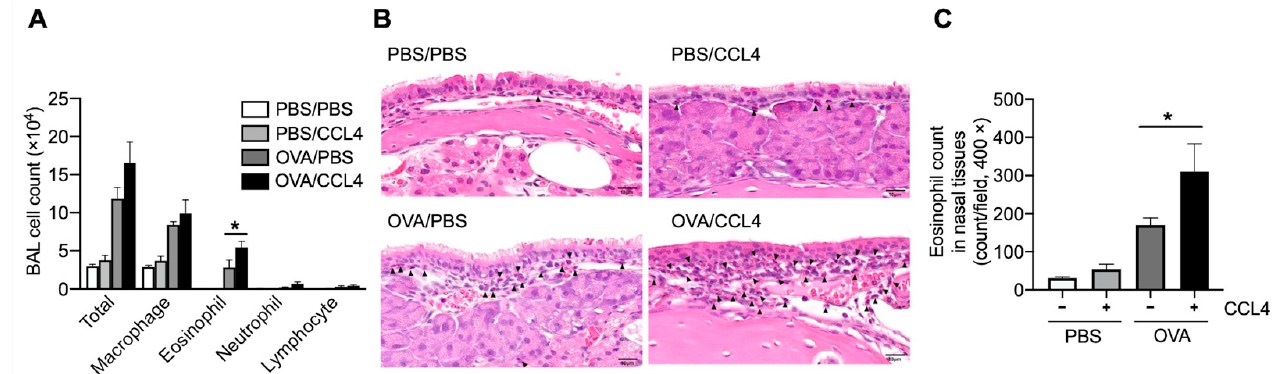
3 of 11 Figure 1. CCL4 expression in airway epithelial cells. ( A ) Immunofluorescence analysis of nasal polyps (NP) with rich eosinophils (Eos) (n = 5) or poor Eos (n = 5), or without Eos (n = 5). CCL4 and EpCAM expression levels were measured. CCL4 (green), EpCAM (orange), MBP (red), and the nucleus (blue) are stained with hematoxylin and eosin (HE) (i). Images were obtained using an FV3000 confocal microscope (100 × objectives). The scale bars in the bottom-right corner indicate 100 μ m. CCL4 intensity is expressed as a fold change relative to EpCAM (ii). The correlation of CCL4 expression with eosinophil count in NPs (iii) and Eos from the peripheral blood (iv). ( B ) CCL4 , CCL5 , CCL11 , and CCL26 mRNA levels were determined in NPs and uncinate process tissues (UTs) obtained from patients with ECRS. ( C , D ) CCL4 expression in BEAS-2B cells co-cultured with purified Eos (from peripheral blood) overnight. CCL4 , CCL5 , CCL11 , and CCL26 mRNA levels were determined ( C ). Images (CCL4, green; nucleus, blue) were obtained using an FV3000 confocal microscopes (200 × objectives) ( D ). Scale bars in the bottom-right corner indicate 10 μ m. The values in B and C represent the mean ± SEM of four experiments. # p < 0.05, ## p < 0.01 (vs. NPs with rich Eos in A, UTs from the same patients in B, and NPs without Eos in C). 2.2. CCL4 Enhances Eosinophil Accumulation into the Local Allergic Inflammatory Site To confirm CCL4’s role in eosinophilic airway inflammation, murine recombinant CCL4 was intranasally administered in a murine model of ovalbumin (OVA)-induced airway inflammation. Further, after OVA challenges and CCL4 administration, eosinophil